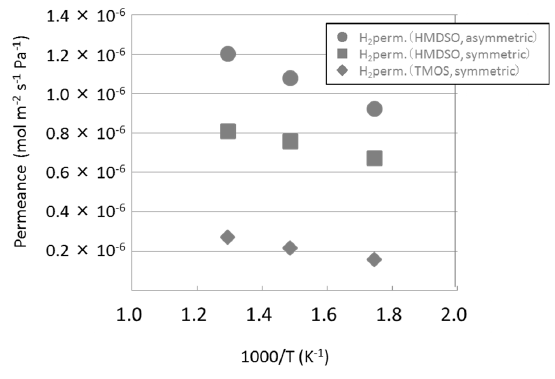
Figure 8. Influence of the substrate to hydrogen permeance of silica membranes. The membranes